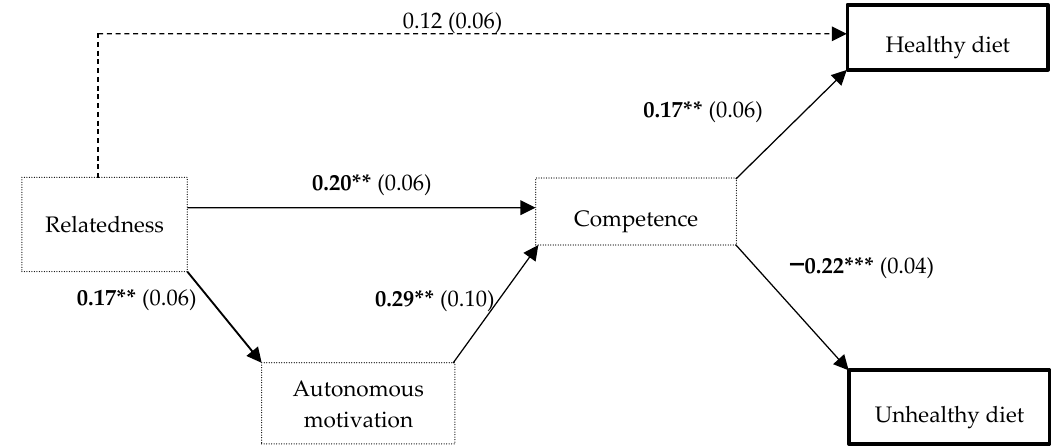
Figure 1. Regression coefficients with standard errors in parenthesis for the direct effects between the SDT and diet pattern variables. Note: Thick squares and dotted squares indicate diet patterns and SDT constructs, respectively. Solid arrows represent significant associations, and dotted arrows represent non-significant associations. Significant β coefficients are bolded. * p < 0 .05; ** p < 0 .01; *** p < 0 .001. Table 6. Indirect effects of the path analysis model.